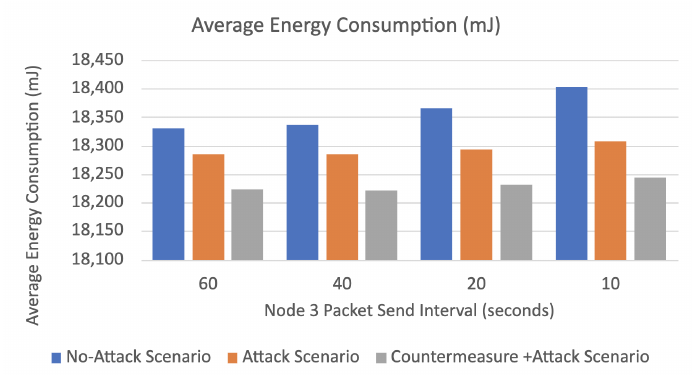
Figure 19. Average energy